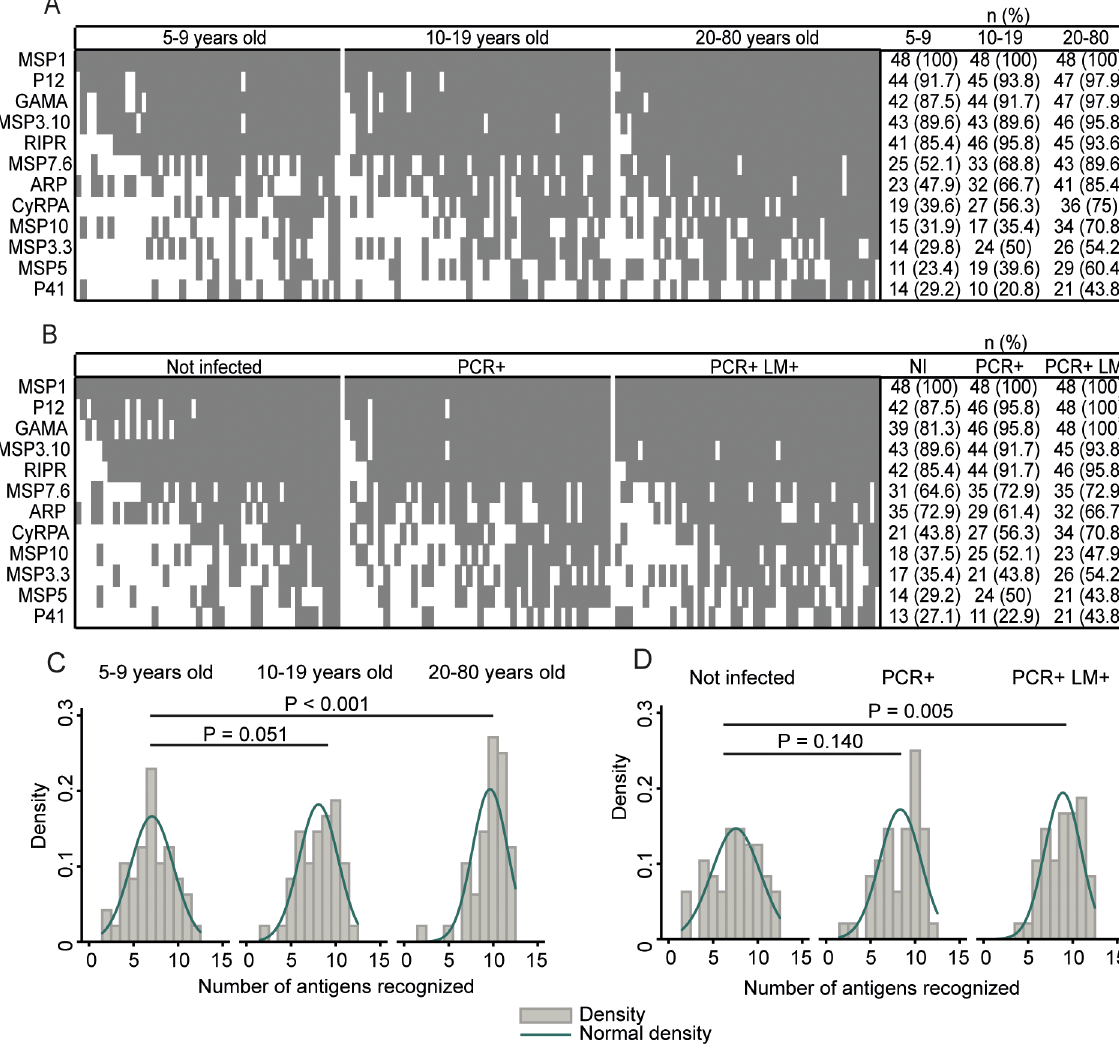
Fig 2. Seroprevalence profiles for 12 P . vivax merozoite antigens in Solomon Islanders. For each antigen, positivity was defined as 2 standard deviations above the mean optical density from Australian malaria-na ï ve adults. (A) and (B) show heatmaps of seroprevalence by age group (5 – 9 years, n = 48; 10 – 19 years, n = 48; 20 – 80 years, n = 48) and by P . vivax infection status (Not infected, n = 48; PCR+, n = 48; PCR+ LM+ n = 48), respectively. Each row shows antibodies observed in all individuals to a single protein, and each column shows antibodies observed in a single individual to all proteins. (C) and (D) show density plots representing the number of antigens recognized in each of the age and infection status groups, respectively. Normally-distributed density curves are shown in dark green. P values are from negative binomial regression and were deemed significant if <